Question: Summarize what this figure shows in one sentence.
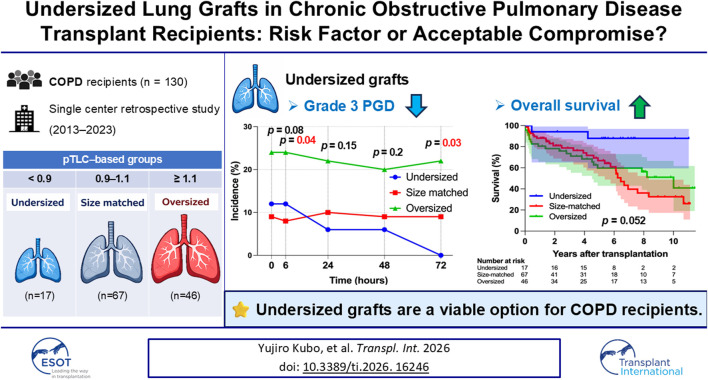
Answer: Graphical abstract of the study. In 130 COPD recipients undergoing bilateral lung transplantation, recipients were divided into the following pTLC-based groups: undersized (<0.9, n = 17), size-matched (0.9–1.1, n = 67), and oversized (≥1.1, n = 46). The undersized group showed lower incidences of grade 3 PGD compared with the other groups. Overall survival was significantly higher in the undersized group compared with the size-matched and oversized groups ( p = 0.018 and p = 0.045, respectively). COPD, chronic obstructive pulmonary disease; PGD, primary graft dysfunction; pTLC, predicted total lung capacity.